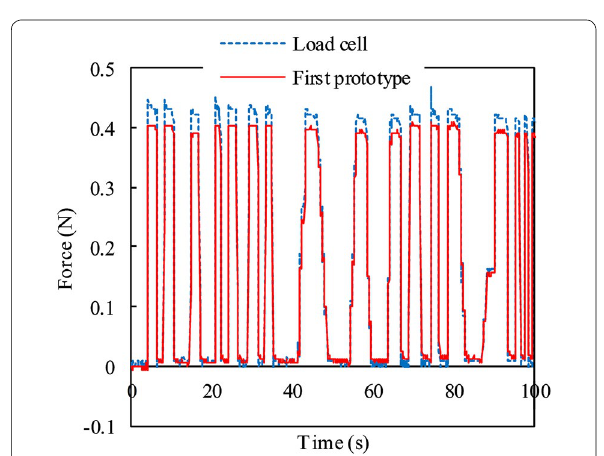
Fig. 6 Comparison of two forces measured by first prototype sensor and load cell when a random force was applied ( T < T g ). Substituting the strain measured by the prototype sensor into the linear approxi- mation formula in Fig. 5, we calculated the applied